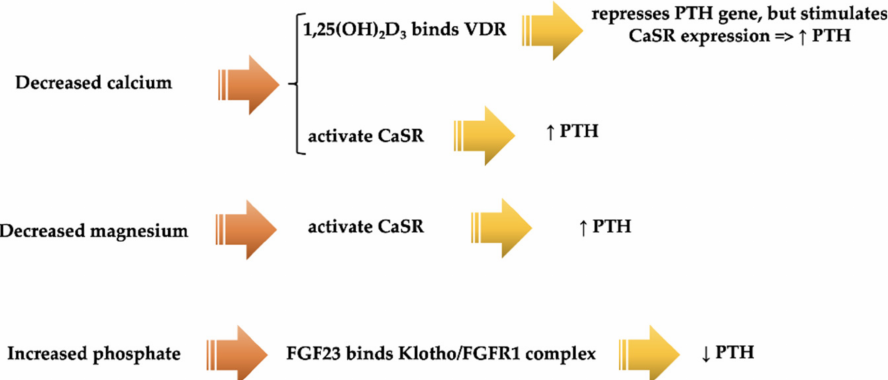
Figure 5. PTH regulatory system within the parathyroid gland, in the case of decreased calcium and magnesium, and increased phosphate (modified after [36]). 1,25(OH) 2 D 3 : vitamin D3 1,25- dihydroxyvitamin D; VDR: vitamin D receptor; PTH: parathyroid hormone; CaSR: calcium-sensing receptor; FGF23: fibroblast growth factor 23; FGFR1: fibroblast growth factor receptor